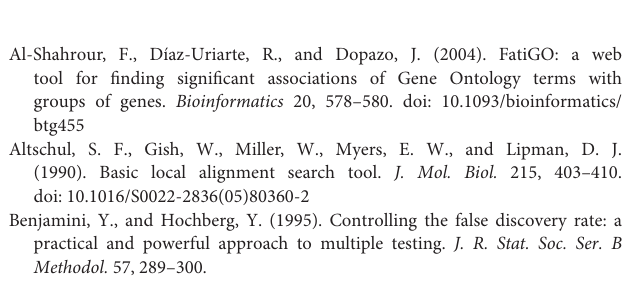
Table S4 | Detailed description of metabolic pathway